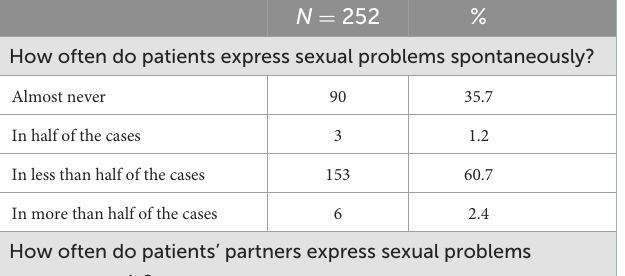
TABLE 4 Participants’ and patients’ attitudes toward discussing sexual life. TABLE 5 Participants’ attitudes and opinions about knowledge in training in sexual